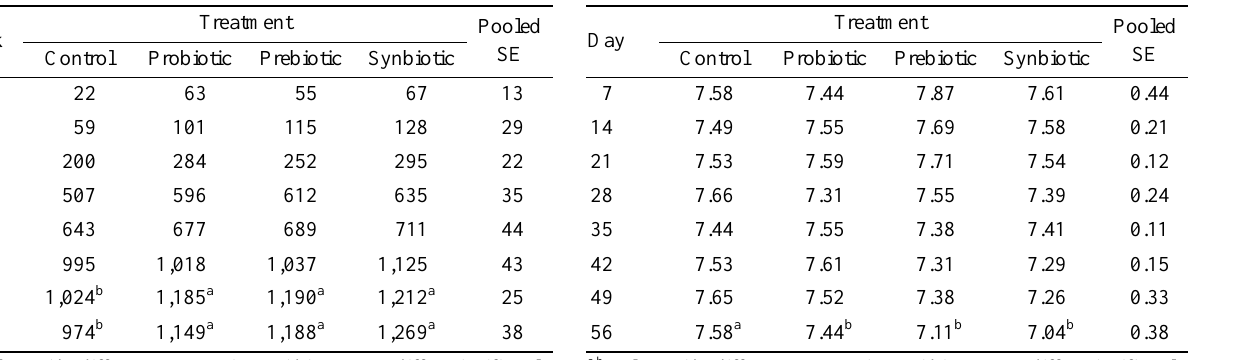
Table 3. Weekly average daily gain (g/d) of calves fed with or without additives